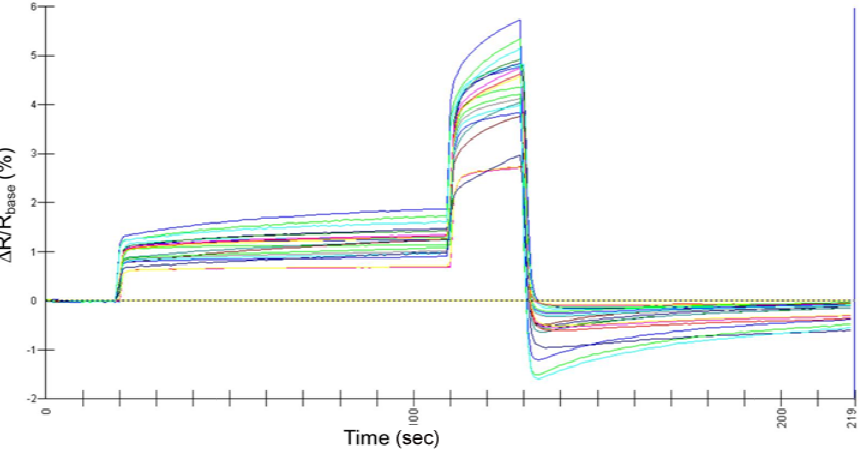
Figure 1. Typical sensor output responses of all e-nose sensor array to headspace volatiles from catfi presence of off-flavor compounds by conductive polymer analyses